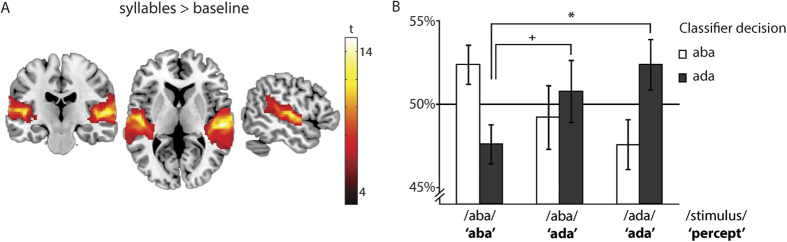
Classification results for auditory stimuli /aba/ and /ada/.(A) Voxel selection for classification. The slices (y = −20, z = 6, x = −52) display the significant group activity map of voxels in primary and secondary auditory cortex that were most active during the localizer (syllables > baseline). The classification analysis was restricted to voxels from this mask. (B) While /aba/ (left bar) and /ada/ stimuli (right bar) that were perceived as such were classified correctly above chance, auditory /aba/ stimuli that were perceived as /ada/ (middle bars) were not classified as ‘aba’ but rather more as ‘ada’. (+p < 00.1, *p < 0.05).